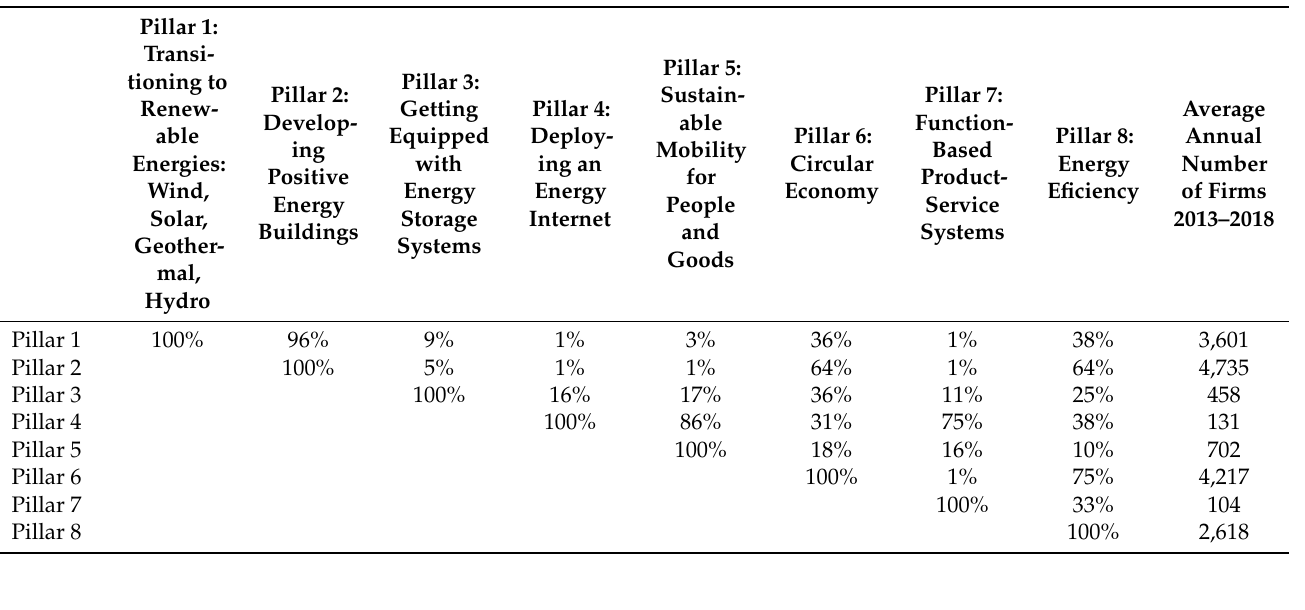
Table 4. Pillar distribution of direct job creation from 2013 to 2018.